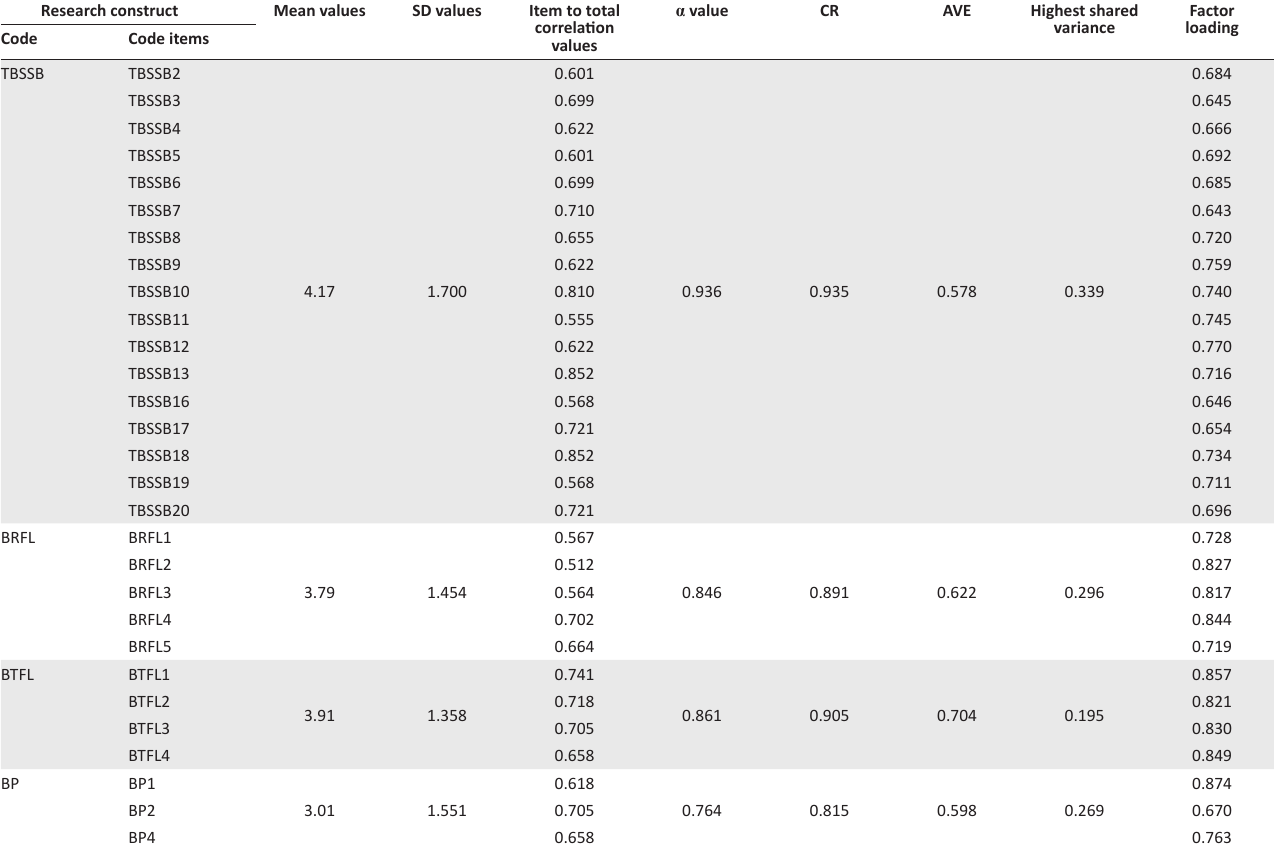
TABLE 2: Accuracy analysis statistics. Research